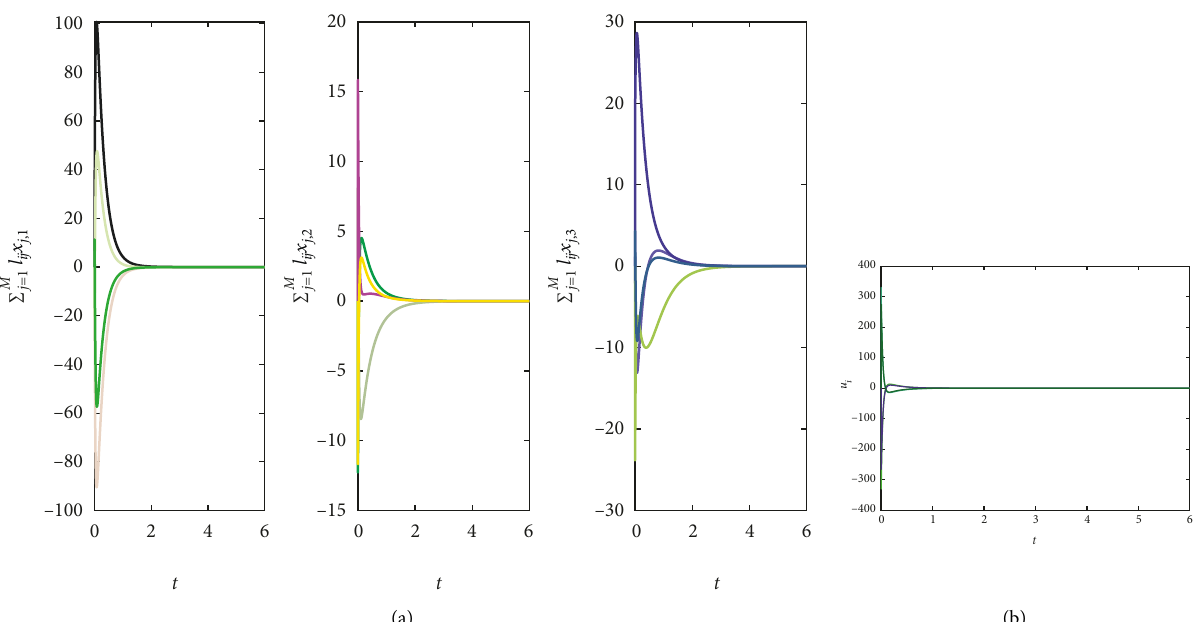
Figure 1: Reduced-order NIO-based consensus. (a) Convergence of 􏽐 N